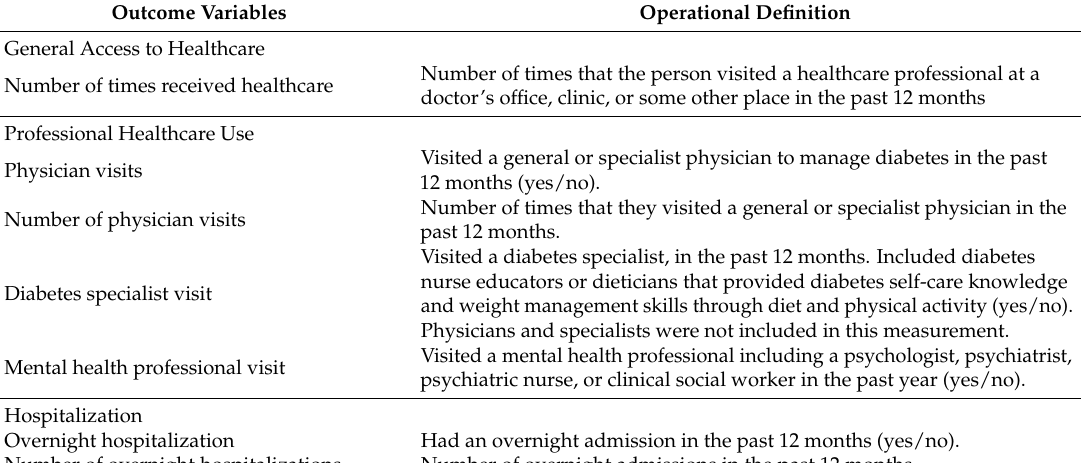
Table 1. Healthcare Utilization (Outcome Variables) and its Measurements among Individuals with Type 2 Diabetes and Depression